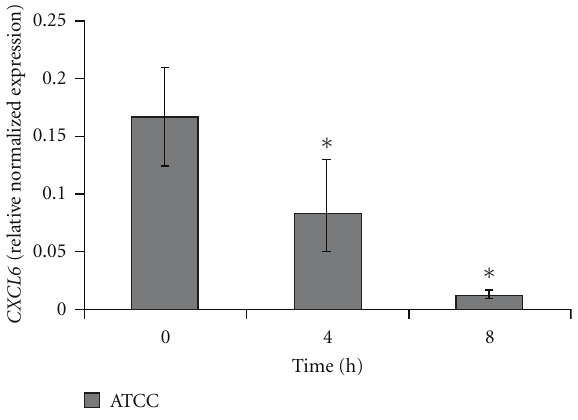
Figure 3: Gene expression of CXCL6 was analyzed by quantitative Real-time RT-PCR. Data shown represent normalized mean expres- sion of CXCL6 ± SEM of up to 4 independent experiments. CXCL6 expression was normalized against h-ALAS housekeeping-gene. ∗ Indicates statistical significant di ff erence ( P < . 05).